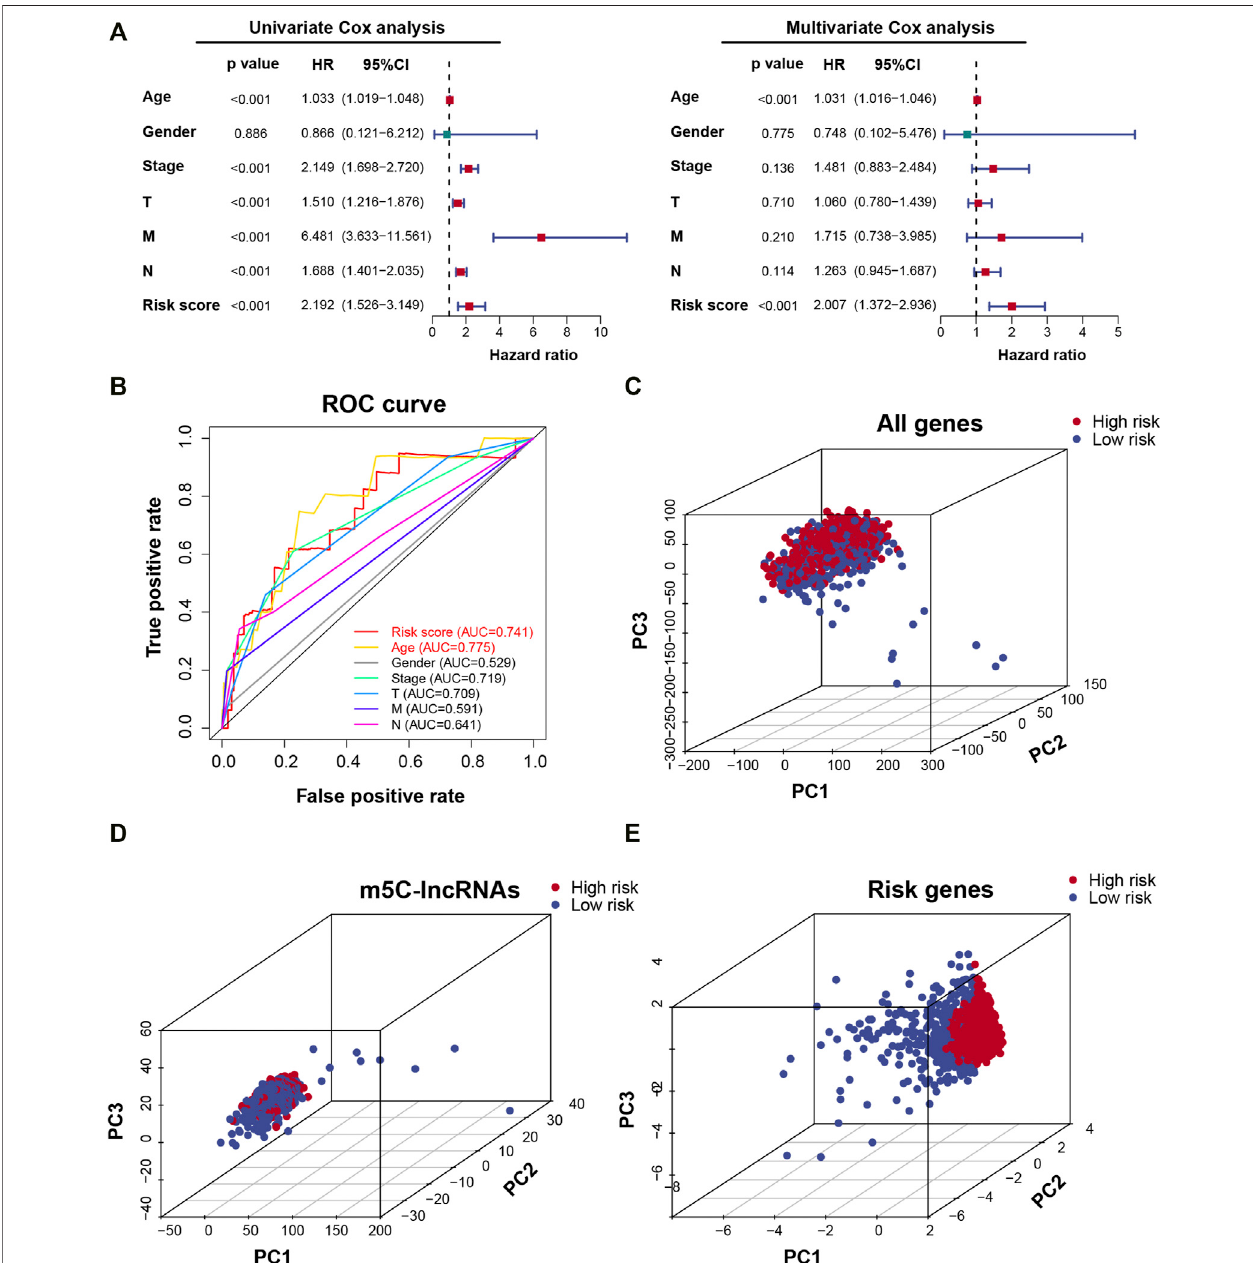
FIGURE 5 | Prognostic risk model veri fi cation. (A) Univariate and multivariate Cox regression analyses of risk scores combined with clinicopathological characteristics. (B) The receiver operating characteristic (ROC) curve veri fi es the sensitivity and reliability of the risk model. (C – E) Principal component analysis between low- and high-risk groups based on the signature of all genes, m5C-lncRNAs, and risk genes.